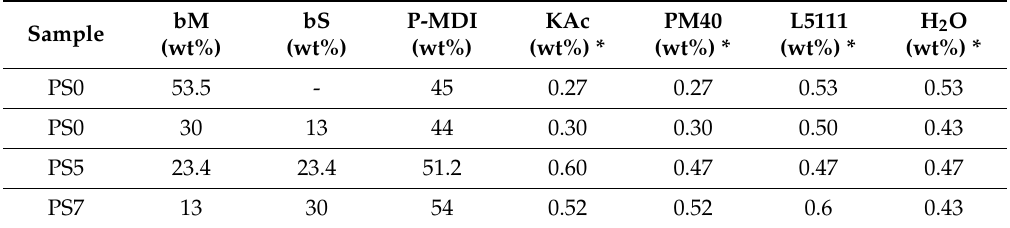
Table 2. Polyurethane foams